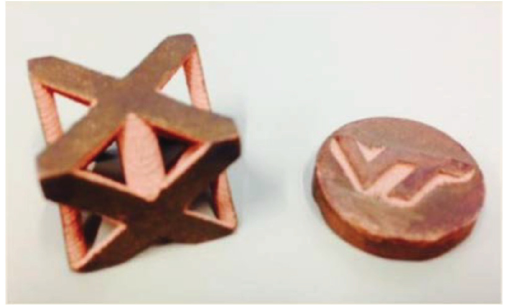
Figure 5. Complex ‐ shaped copper made via binder jetting. Adapted from [19], MDPI,